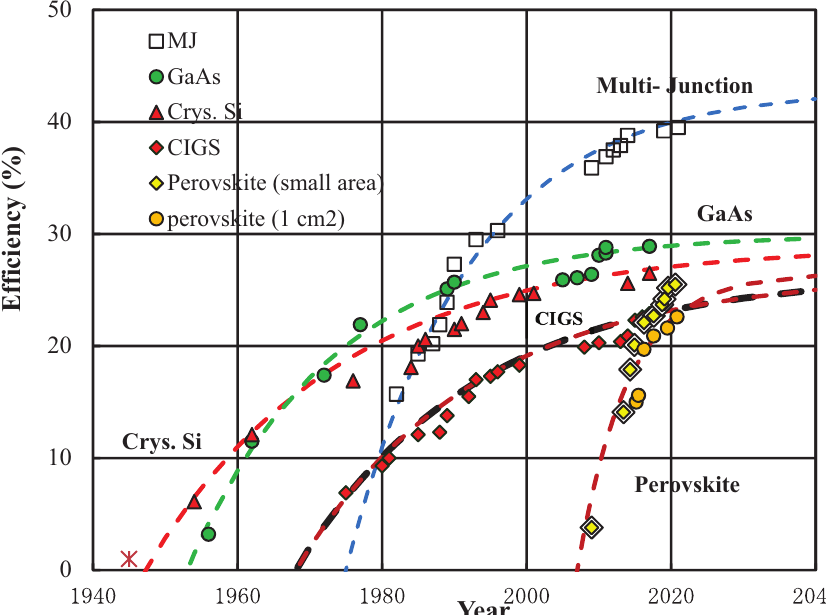
Fig. 2. Chronological ef fi ciency improvements of crystalline Si, GaAs, CIGS, and perovskite single-junction solar cells and III – V compound multi-junction (MJ) solar cells under 1-sun